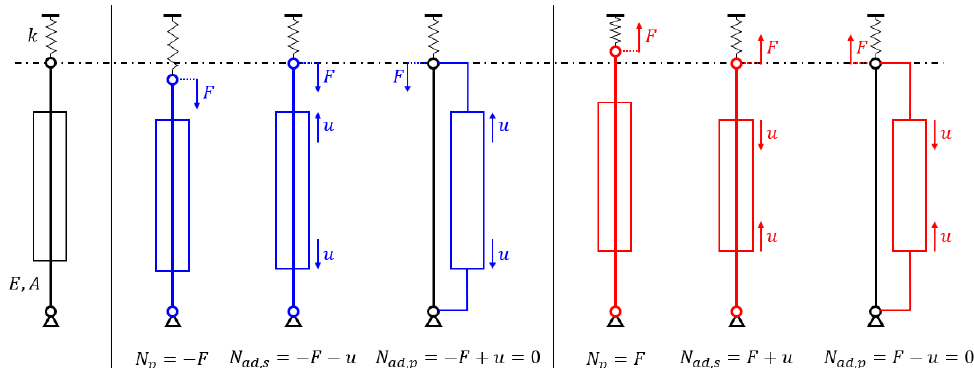
Figure 2. Schematic of an actuated column with Young’s Modulus E , cross-section A and constraining stiffness k , from left to right: static system; column under external compressive load F ; deformation compensation through serial actuation u and resulting superposition of compressive normal forces N ; deformation compensation through parallel actuation and resulting distribution of normal forces in the column and actuator; column under external tensile load; deformation compensation through serial actuation and resulting superposition of tensile normal forces; deformation compensation through parallel actuation and resulting distribution of normal forces in the column and actuator.